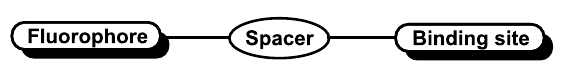
Figure 1: Design principle for 1 and 2